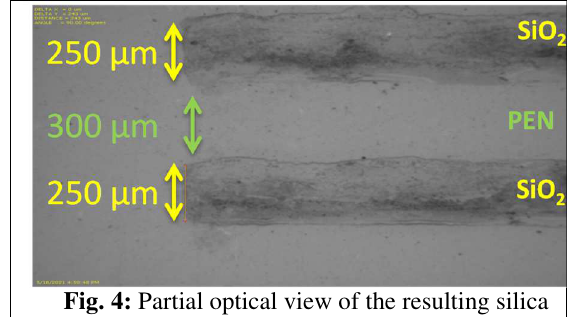
Fig. 4: Partial optical view of the resulting silica strips (250 µm width and apart by 300 µm).